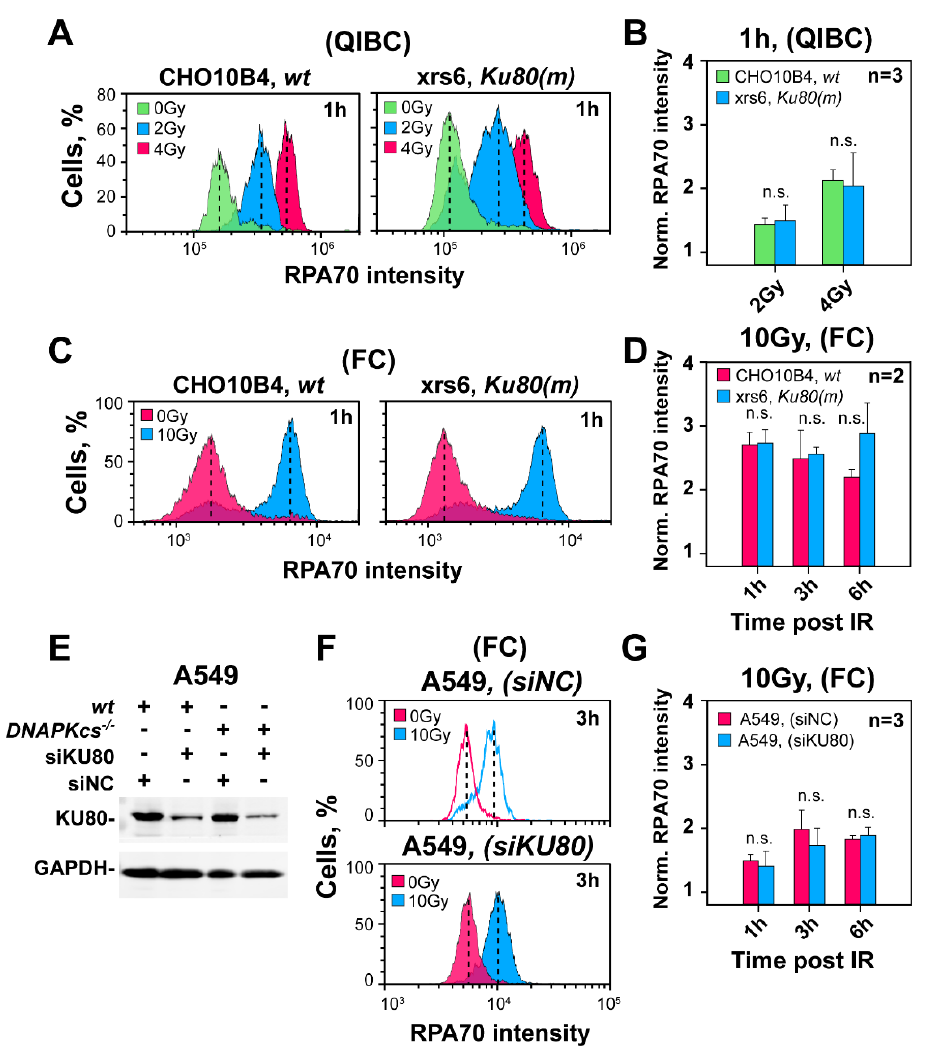
Figure 3. Ku deficiency leaves unchanged resection in G 2 -phase. ( A ) As in Figure 1B in CHO10B4( wt ) and the Ku80-deficient mutant, xrs6. ( B ) As in Figure 1C for the cell lines in panel ( A ). ( C ) As in panel ( A ), following analysis by FC. ( D ) Quantitative analysis of results shown in panel ( C ). ( E ) Western blot showing the levels of Ku in A549 cells transfected with a siRNA targeting Ku80, or a non-specific control siRNA. ( F ) As in panel ( C ) for A549 cells transfected with a Ku80 specific siRNA, or a non-specific control siRNA. ( G ) As in panel ( D ) for the conditions shown in panel ( F ). n.s. indicates